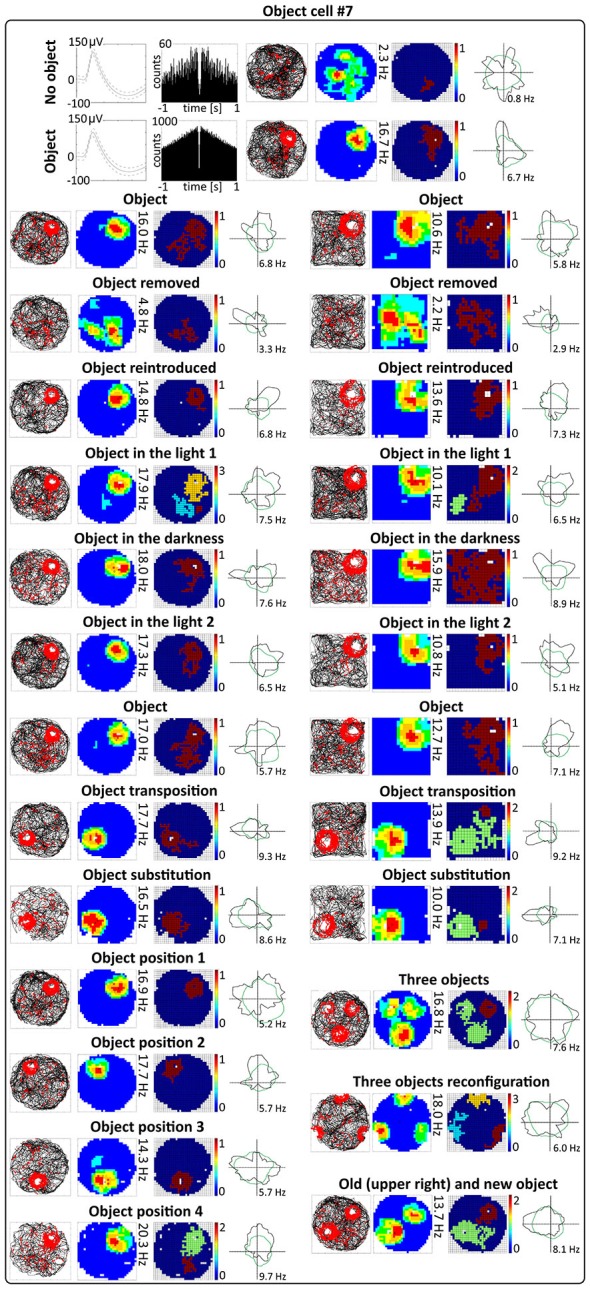
Environmental manipulations for a representative claustral object cell. Top: two consecutive recording sessions with and without presentation of the object (glass bottle). For each recording session in rows are presented: spike waveform: autocorrelation ± 1000 ms; path of the animal recorded during 20 min session with superimposed firing activity: firing intensity map with a maximum firing frequency, place map and polar plot. Bottom, recording sessions with environmental manipulations. The visual cue was located in the same place as in Figure 1 in baseline conditions. On the left, sets of consecutive recording sessions in circular arena with following transitions: object–no object–object; light–dark–light; object–object transposition–object substitution (substitution with object of different shape, color and material—painted wooden brick); object in position 1–2–3–4. On the right, consecutive recording sessions in the square arena with the following transitions: object–no object –object; light–dark–light; object–object transposition–object substitution. Below on the right, samples of recordings with presentation of three objects in two different spatial configurations and with simultaneous presentation of old and new object (plastic object presented to the animal for the first time). For all transitions in rows are shown: path of the animal; firing intensity map; place map and polar plot.